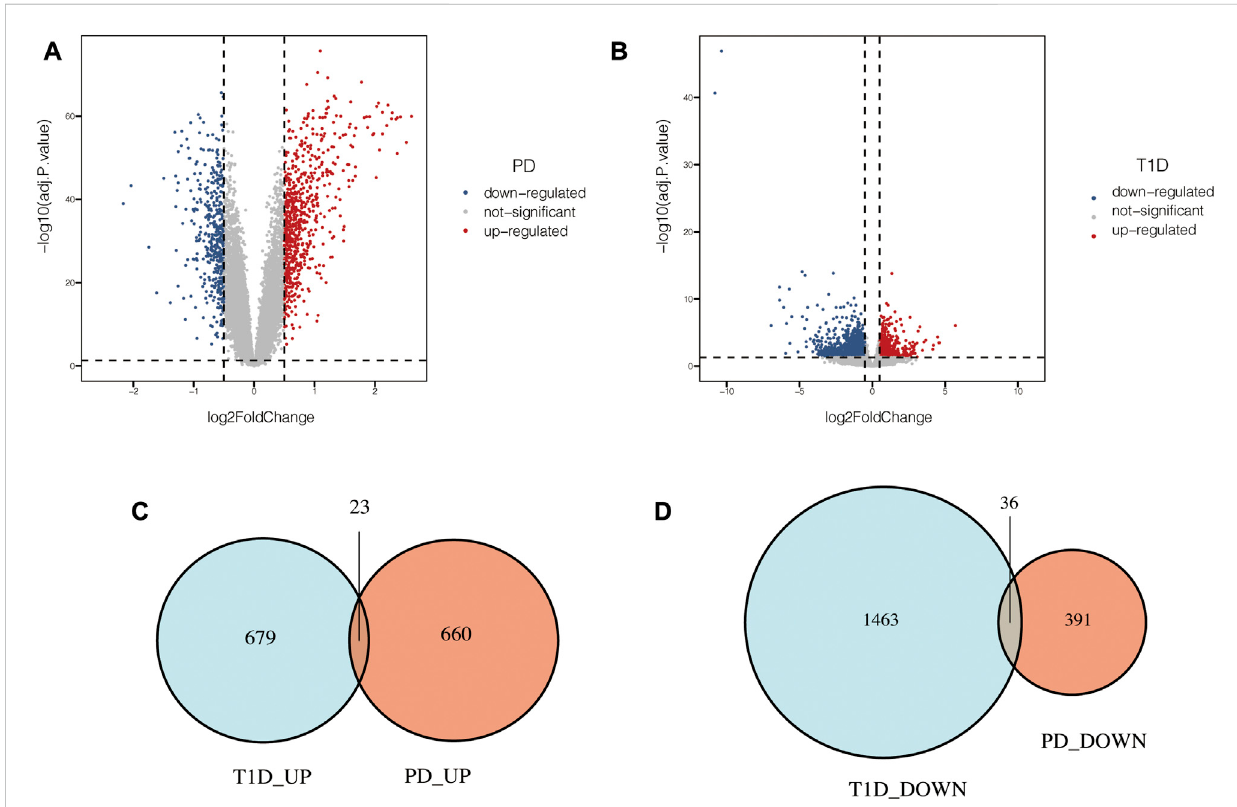
FIGURE 3 Common DEGs in PD and T1D. (A) Volcano plots of DEGs identi fi ed in PD datasets. (B) Volcano plots of DEGs identi fi ed in T1D datasets. (C) Venn diagram of upregulated common DEGs. (D) Venn diagram of downregulated common